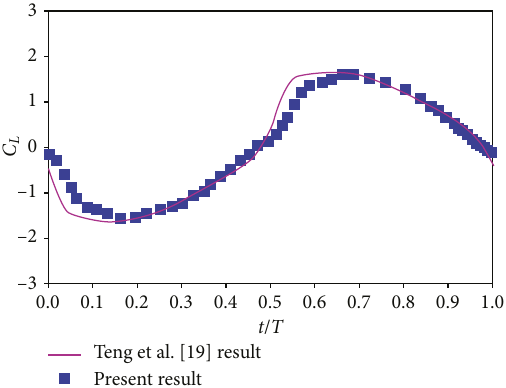
Figure 4: The lift coe ffi cient of a semiactive fl apping wing.